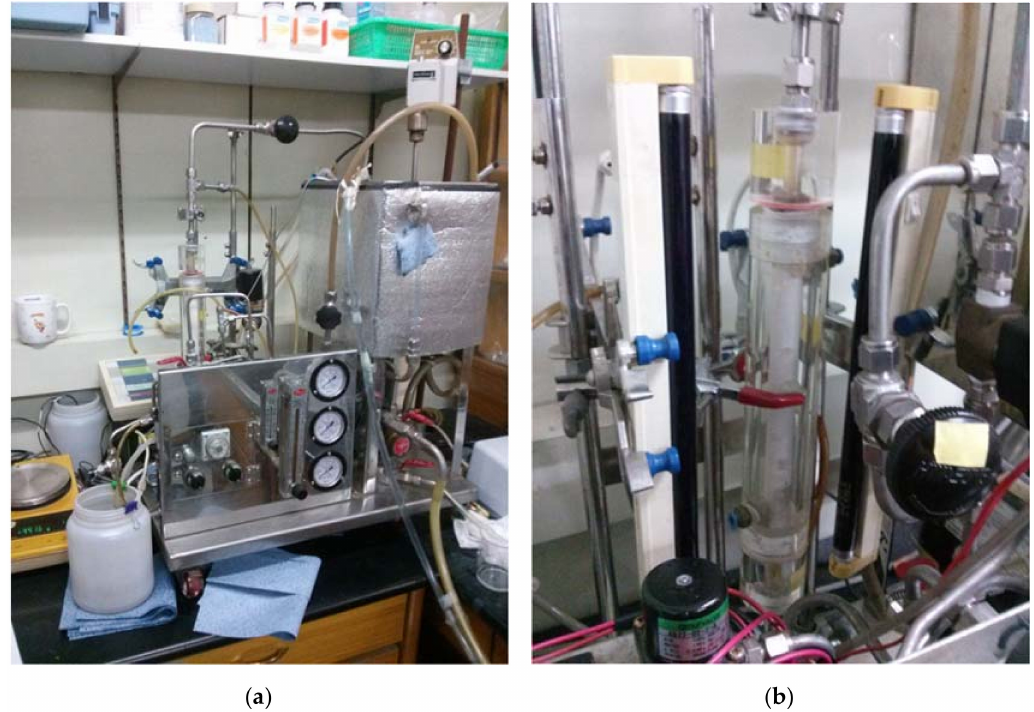
Figure 1. Apparatus of hybrid water treatment process of tubular carbon fiber ultrafiltration (UF)and microfiltration (MF) membrane and PP beads with periodic water backwashing